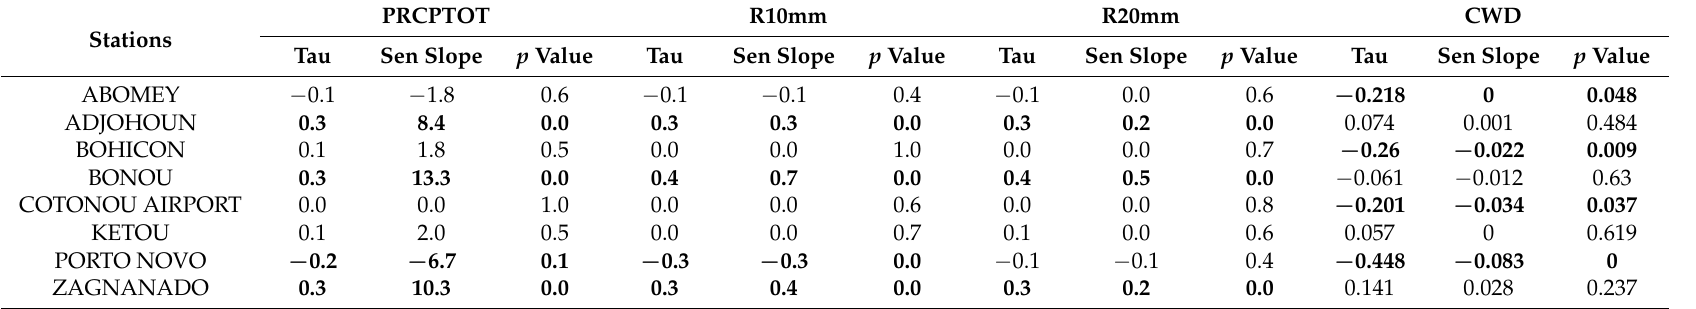
Table 3. Significant trend results of annual rainfall intensity